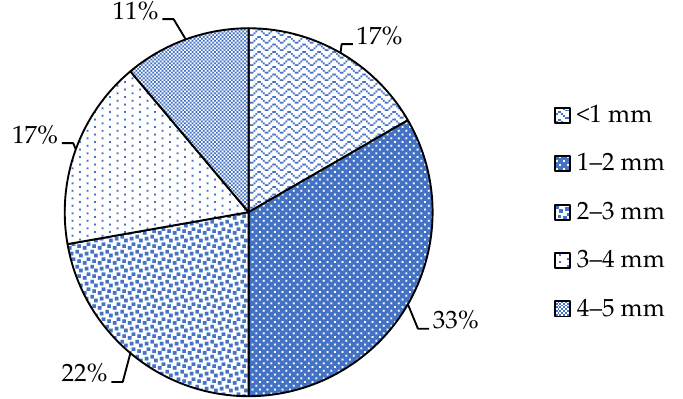
Figure 4. A comparison of the literature data of percentages frequency of different fiber lengths in biota and water samples from the Mediterranean Sea.